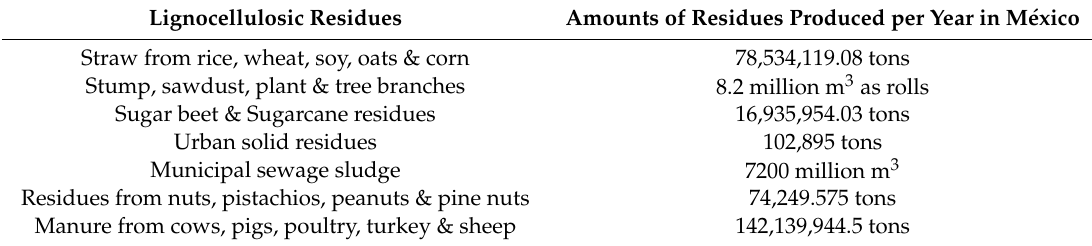
Table 1. A brief summary of lignocellulosic residues generated in Mexico.